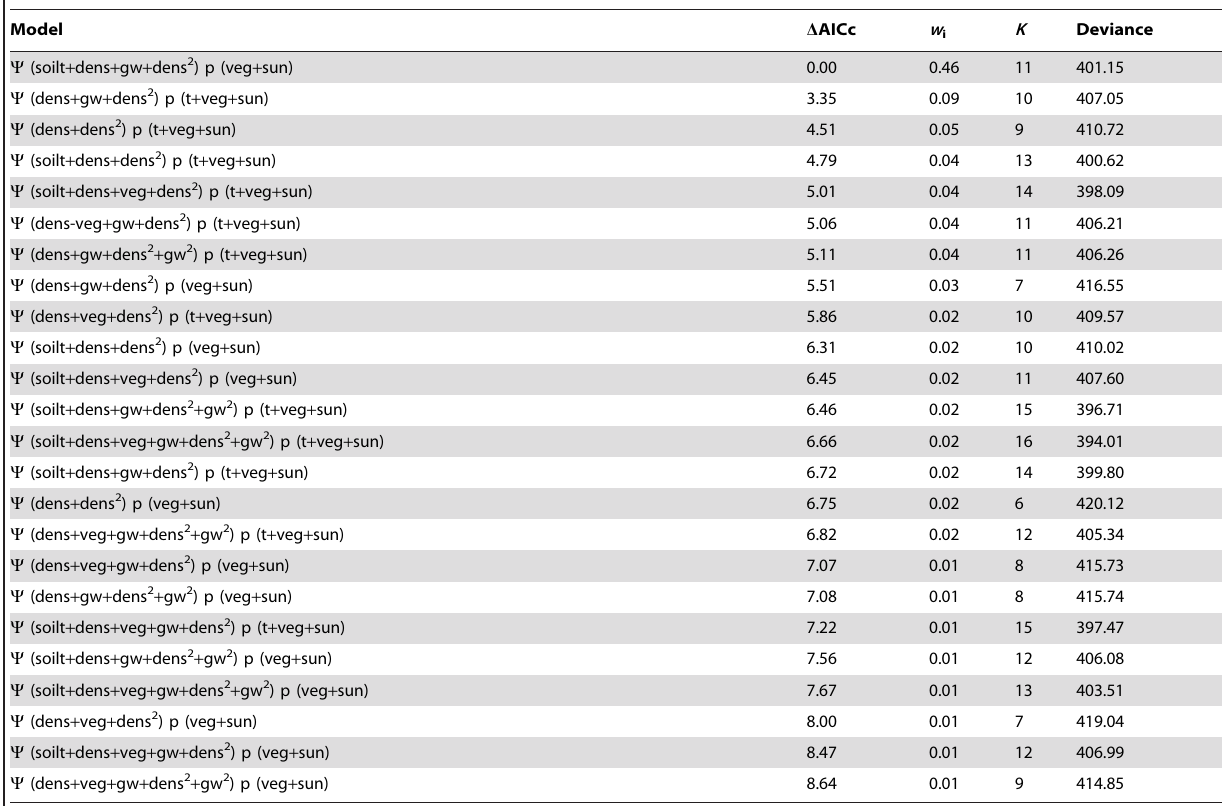
Table 3. Mole cricket occupancy